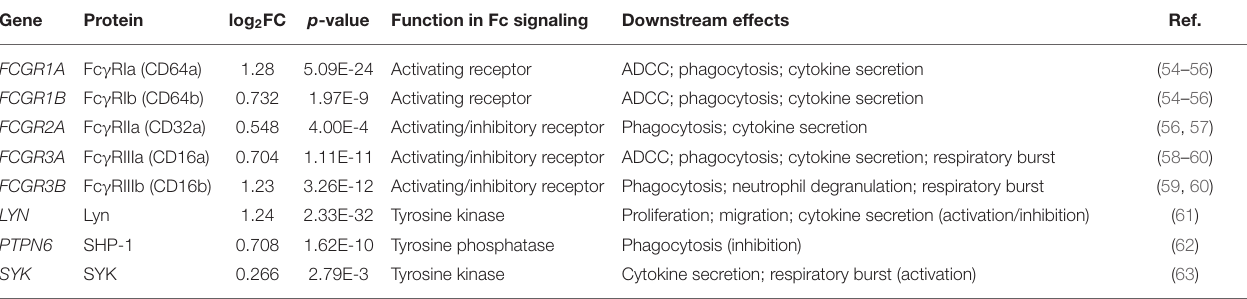
TABLE 1 | Genes related to Fc γ signaling are upregulated in monocytes/macrophages of HS lesions compared to healthy control skin. Gene Protein log 2 FC p -value Function in Fc signaling Downstream effects Ref.